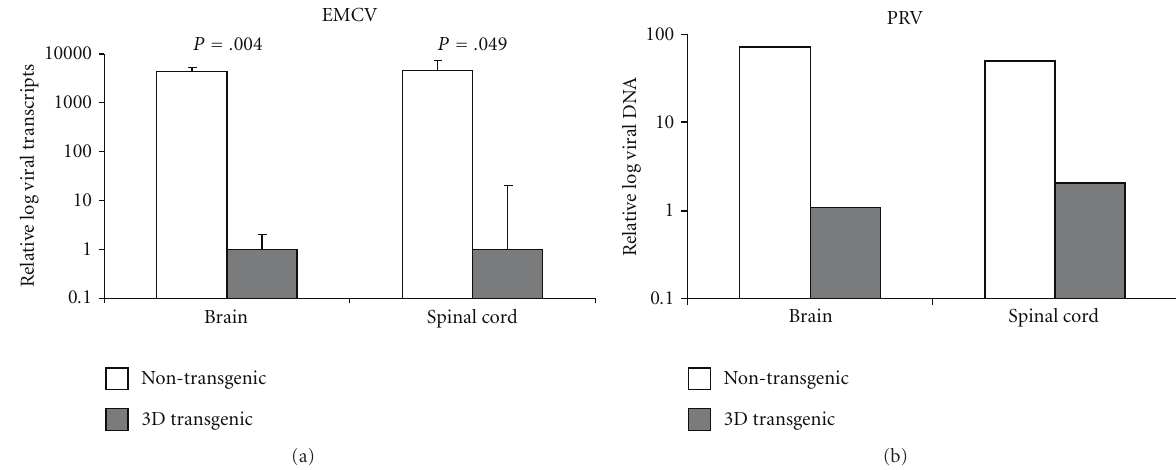
Figure 5: Viral load in mice infected with EMCV or PRV. (a) Viral transcripts in EMCV infected mice. Nontransgenic and 3D transgenic FVB mice were infected with 40 plaque forming units of EMCV (VR-129B ATCC) intraperitoneally. Brain and spinal cord were harvested after 3 days and total RNA was isolated using Trizol reagent (Invitrogen). Viral transcripts for EMCV were quantified by real-time PCR using primers specific for the VP2 region of EMCV. Data were normalized to GAPDH transcripts and are expressed as mean relative viral transcripts + SEM ( n = 3 for nontransgenic and 4 for 3D transgenic). Data was statistically significant using a two-tailed student’s t -test assuming unequal variance. (b) Viral DNA in pseudorabies virus (PRV) infected mice. Nontransgenic and 3D transgenic FVB mice were infected with 2 × 10 7 plaque forming units of PRV 152 intramuscularly in the left hind limb. Brain and spinal cord were harvested after 7 days and DNA was isolated. Viral DNA for PRV was quantified by real-time PCR using primers specific for the inserted EGFP in PRV 152. Data are expressed as mean relative viral DNA ( n = 2 for nontransgenic and 3 for 3D transgenic) and were normalized to genomic IL-2